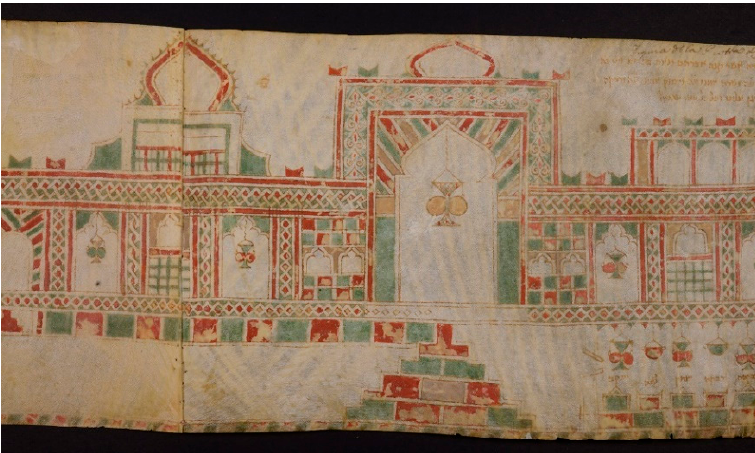
Figure 5. Florence, BNC, Ms. Magl. III, 43; The Cave of the Makhpela in Hebron, early 14th century, by courtesy of Ministero dei beni e delle attività culturali e del turismo/Biblioteca Nazionale Centrale di Firenze.